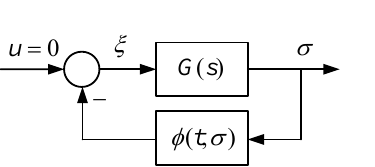
Fig. 16. Nonlinear system analyzed by the circle.